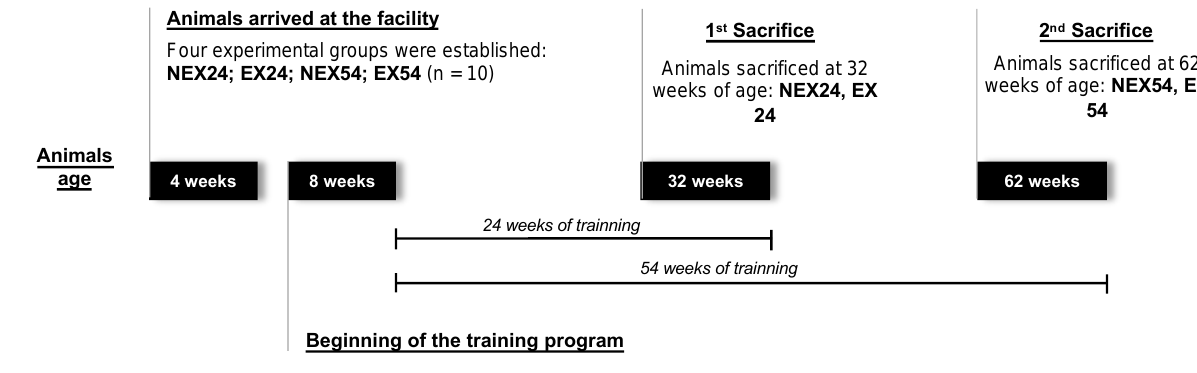
Figure 1. Experimental design.